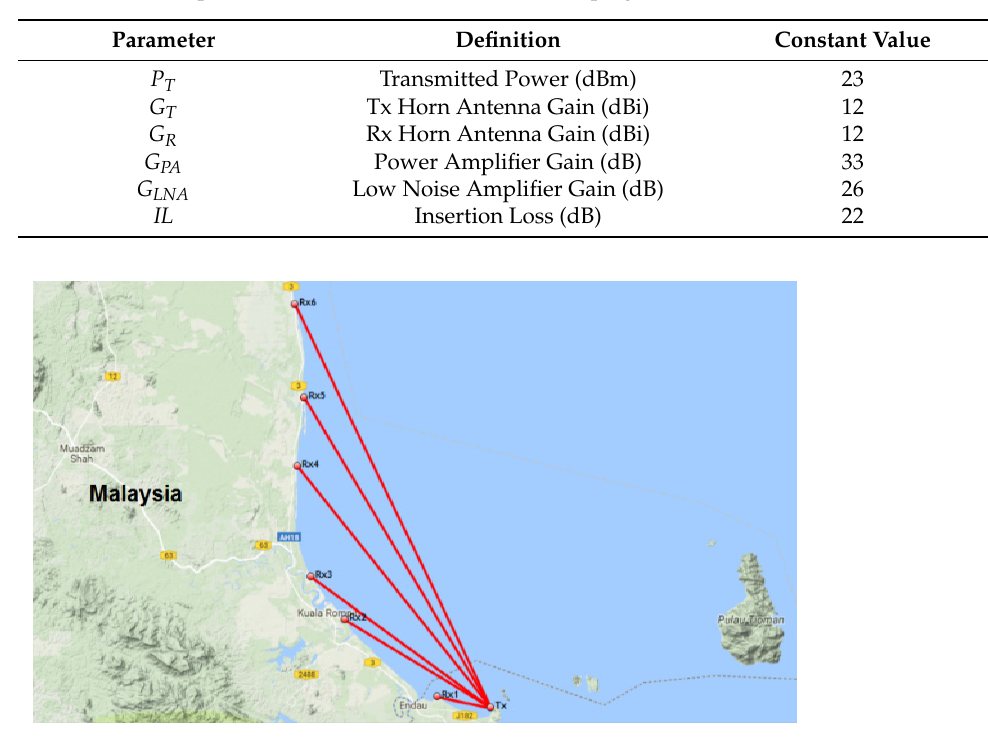
Figure 2. Google Map of six link paths for measurement campaign over the Malaysian Region of the South China Sea from 10 km to 100 km.